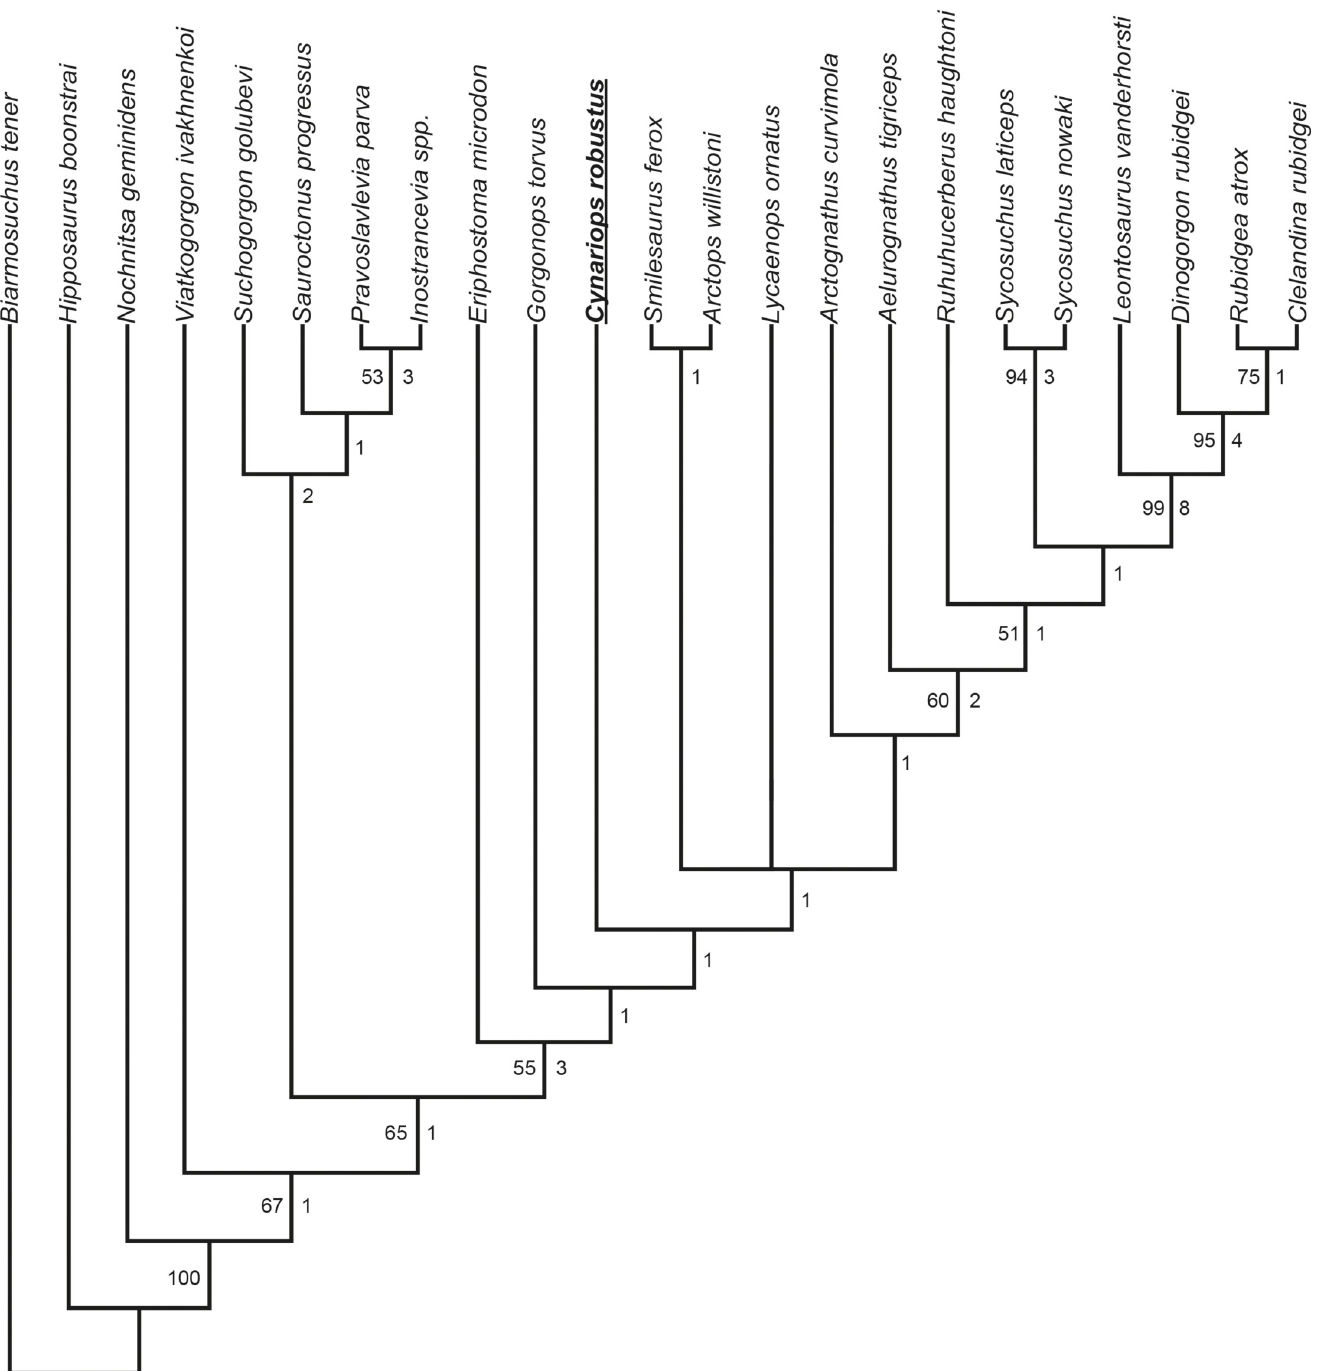
Fig 16. Strict consensus tree of gorgonopsian phylogenetic analysis, including MB.R.999 (= Cynariops robustus ). Numbers left under nodes indicate bootstrapping support values above 50%. Numbers right under nodes show Bremer support indices.